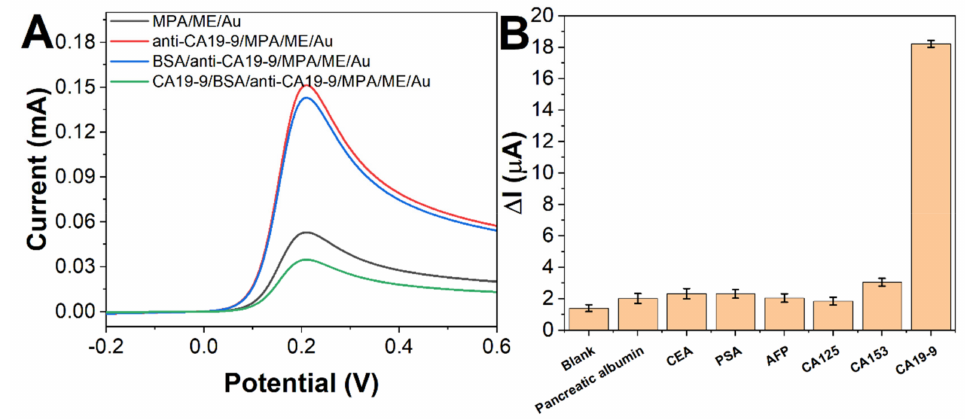
Figure 4. ( A ) DPV curves of MPA/ME/Au, anti-CA19-9/MPA/ME/Au, BSA/anti-CA19-9/MPA/ ME/Au, and CA19-9/BSA/anti-CA19-9/MPA/ME/Au in 5 mM [Fe(CN) 6 ] 3 − /4 − . Scan rate: 20 mV/s. ( B ) Electrochemical detection of 5 ng/mL pancreatic albumin, CEA, PSA, AFP, and 5 U/mL CA125, CA153,